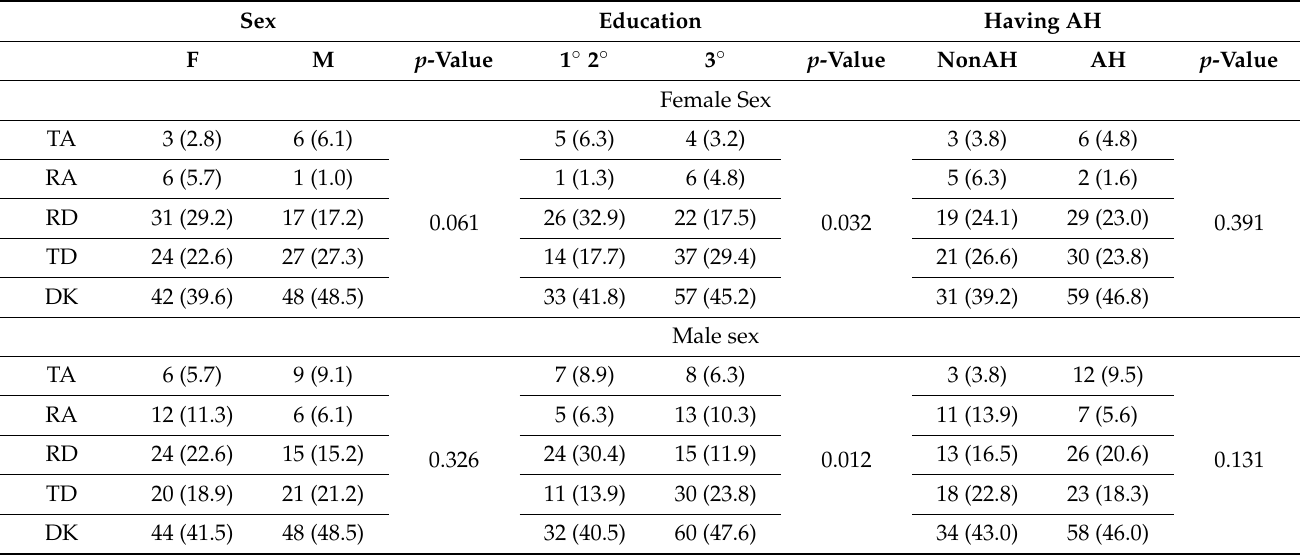
Table 12. Being a woman as a factor that increases the incidence of hypertension by gender, education, and having hypertension (N = 205).